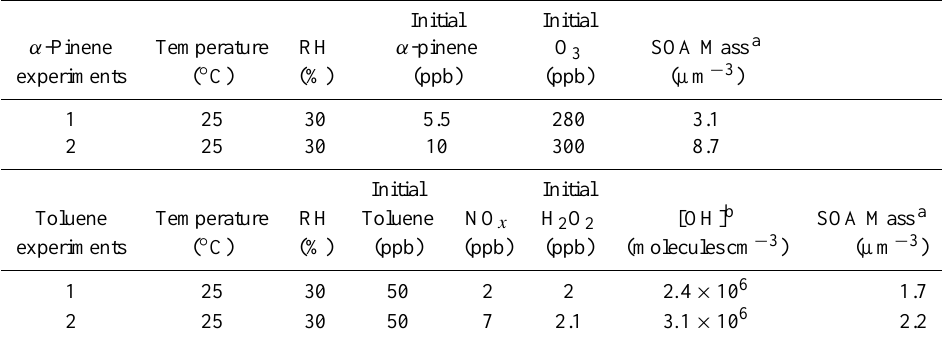
Table 1. Experimental conditions used in α -pinene dark ozonolysis and toluene photooxidation experiments.